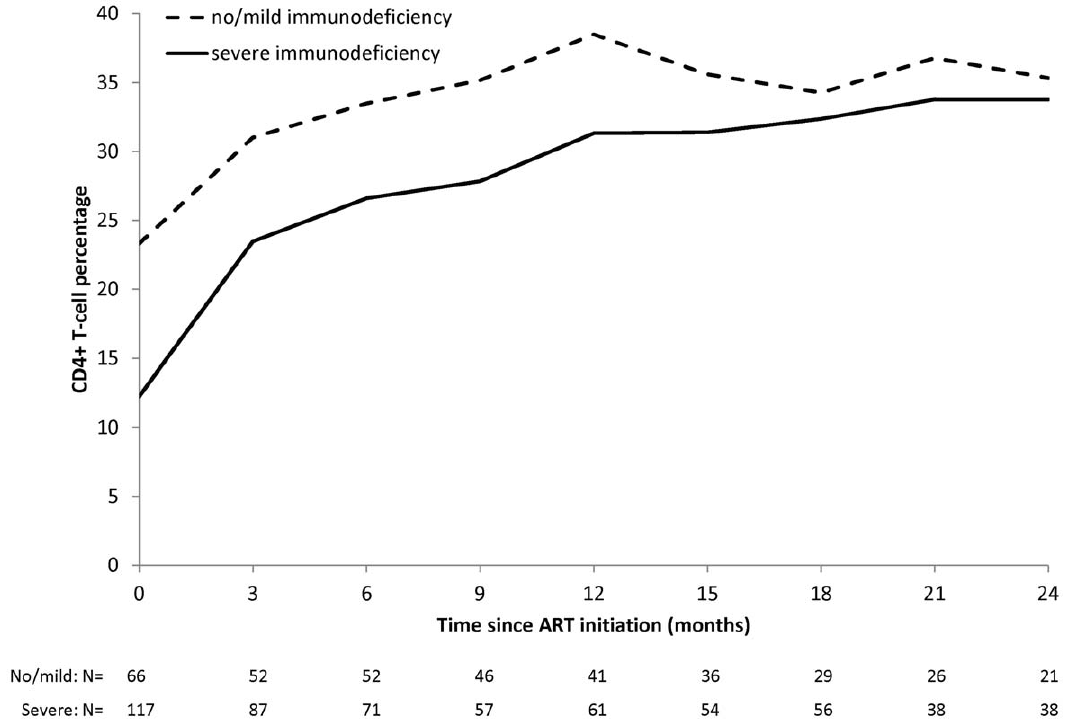
Figure 1. Mean CD4 + T-cell percentage (95% CI) after ART initiation, by level of immunodeficiency at initiation. doi:10.1371/journal.pone.0019006.g001 PLoS ONE |